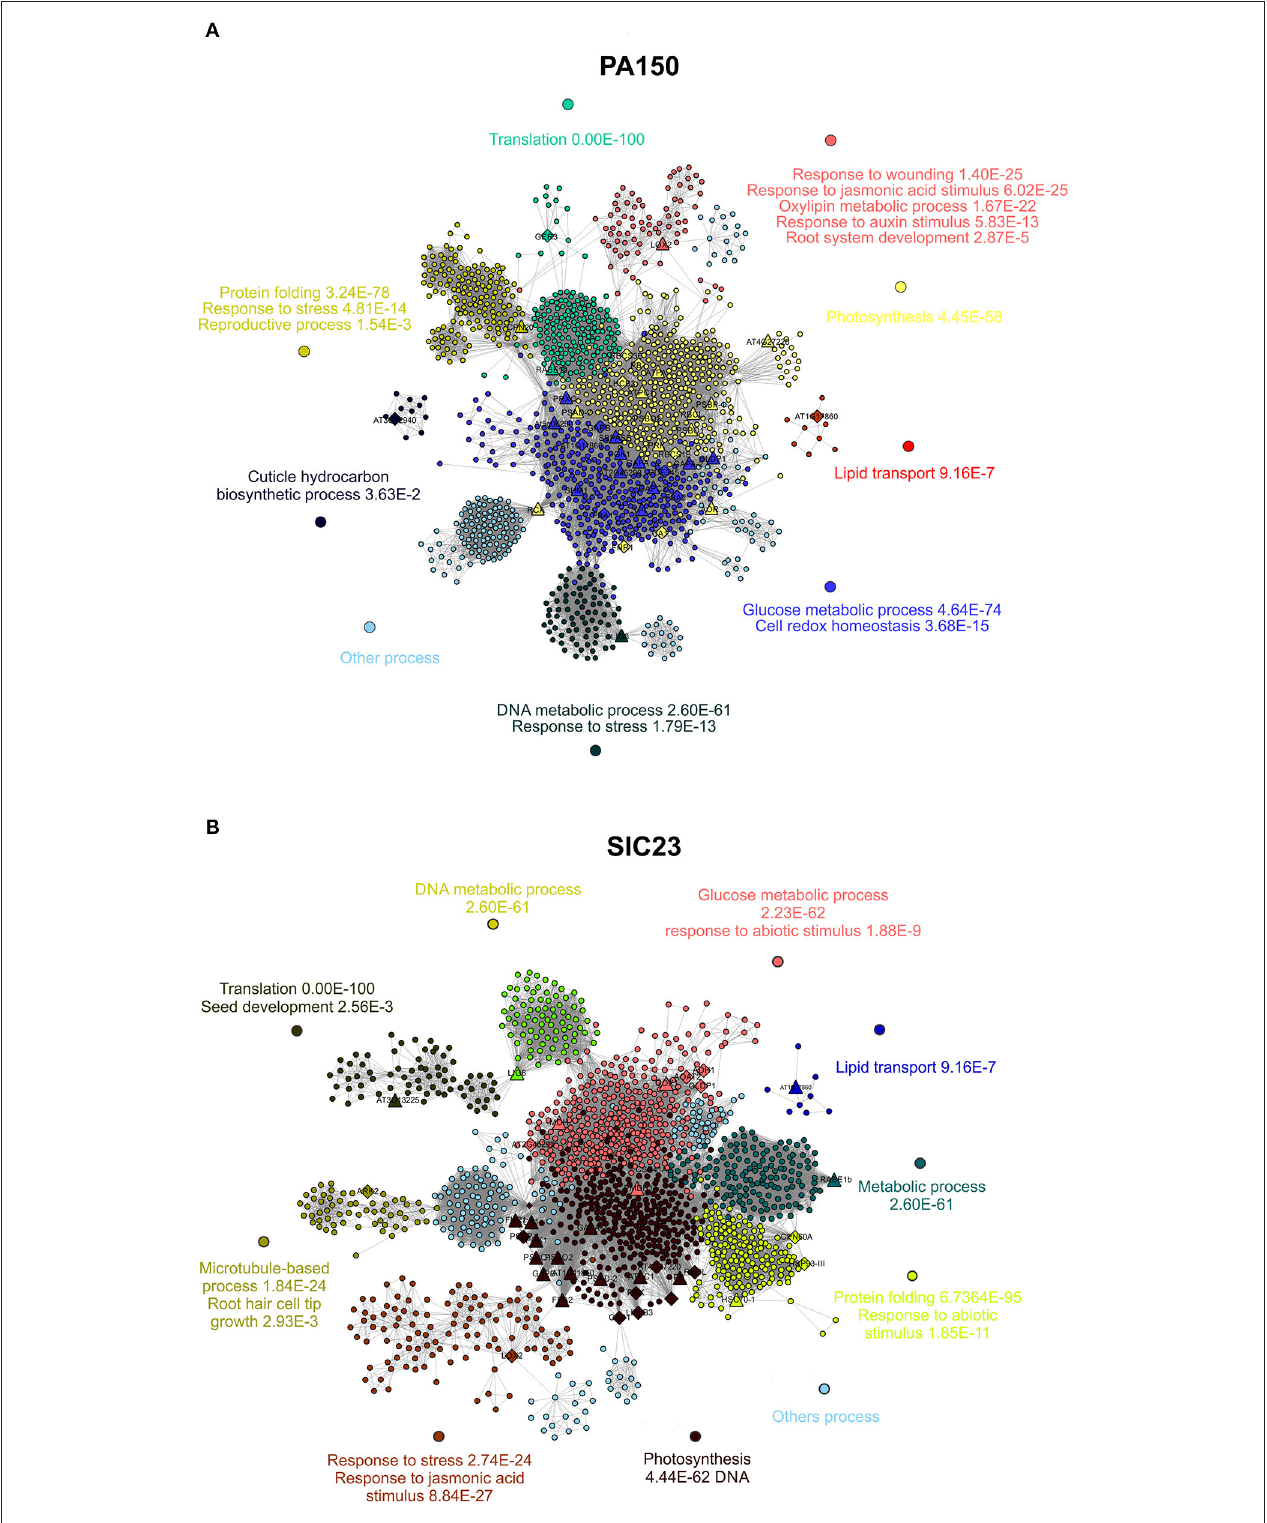
FIGURE 3 | Protein interaction networks of A. thaliana . Interaction network of the proteins of A. thaliana homologous to those identified in leaves from (A) resistant clone PA 150 and (B) susceptible clone T. cacao , 48 hai with P. palmivora . Each knot represents a protein; the larger knots in triangle shape represent proteins homologous to those identified in T. cacao as up-accumulated and the larger knots in diamond shape represent the proteins homologous to those identified in T. cacao as down-accumulated. The networks were divided into clusters, each represented by a color. At least one biological function with its p -value was attributed to each